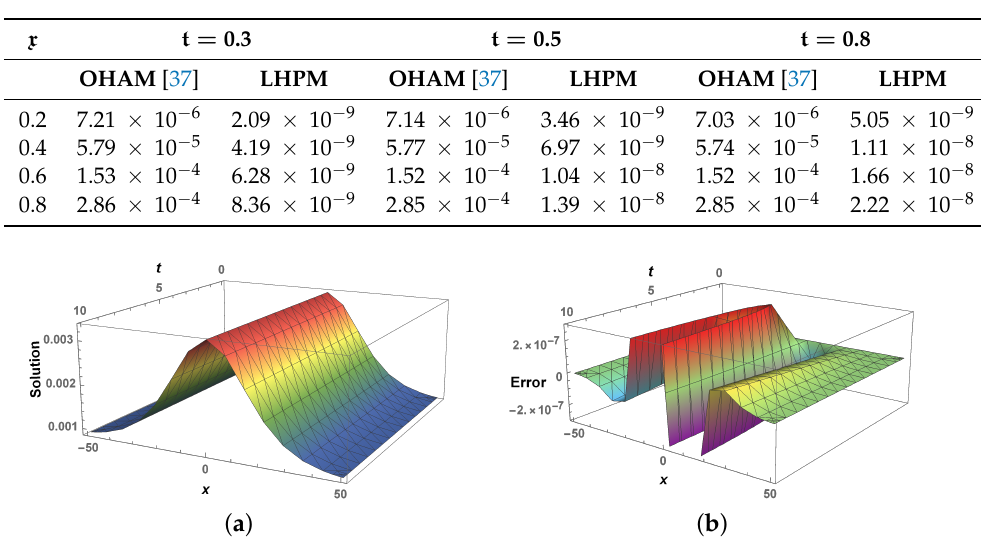
Figure 10. 3D graphical illustration of LHPM solution ( a ) and error ( b ) in Example 4 when β = 1, λ = 0.1, w = 1, ρ = 2.5, and µ = 0.